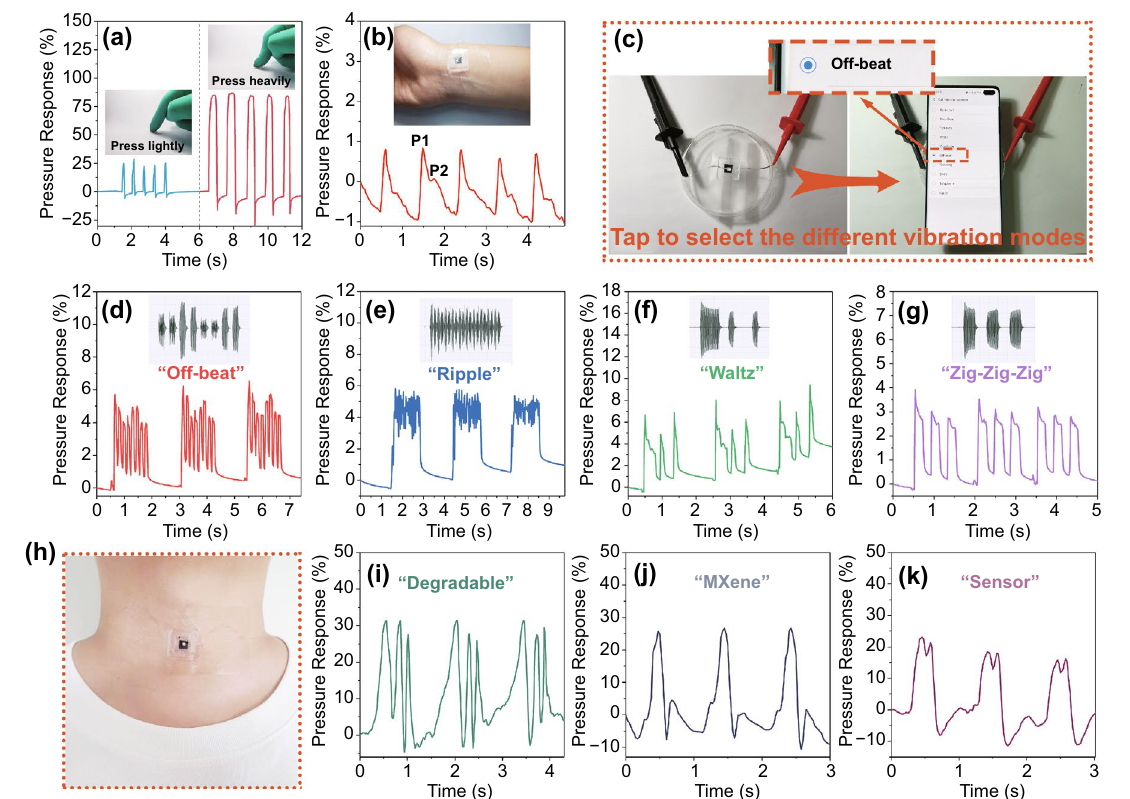
Fig. 5 a The response results of manual press on the sensor. b Real-time recording of the radial artery blood pressure waveform, inset shows the photograph of the wearable sensor attached to the human wrist. c Photos of the vibration test of the mobile phone (Samsung S10 Plus). Real- time resistance changes of the pressure sensor during detecting the four different vibration modes of the mobile phone: d “Off-beat,” e “Ripple” and f “Waltz” and g “Zig-Zig-Zig.” h The photo of the pressure sensor in the throat. The response signal waveform of the pressure sensor toward sounds: i “degradable,” j “MXene,” and k